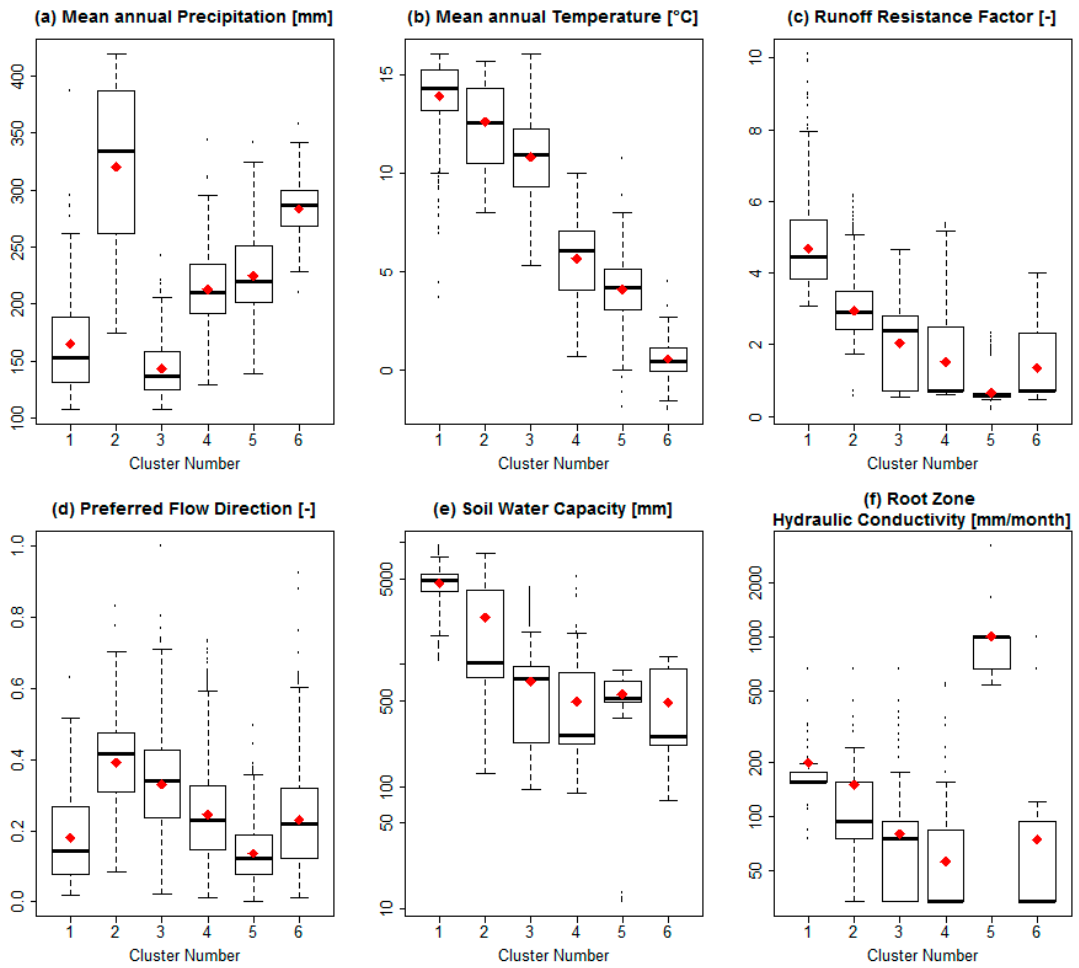
Figure 6. Boxplots per cluster in the simulation HRU_06 for: ( a ) Mean annual precipitation, ( b ) mean temperature, ( c ) RRF, ( d ) f, ( e ) Sw and ( f ) Ks. Red circles represent the mean value of each cluster. Sw and Ks are plotted on a log scale. Means are shown as red dots.